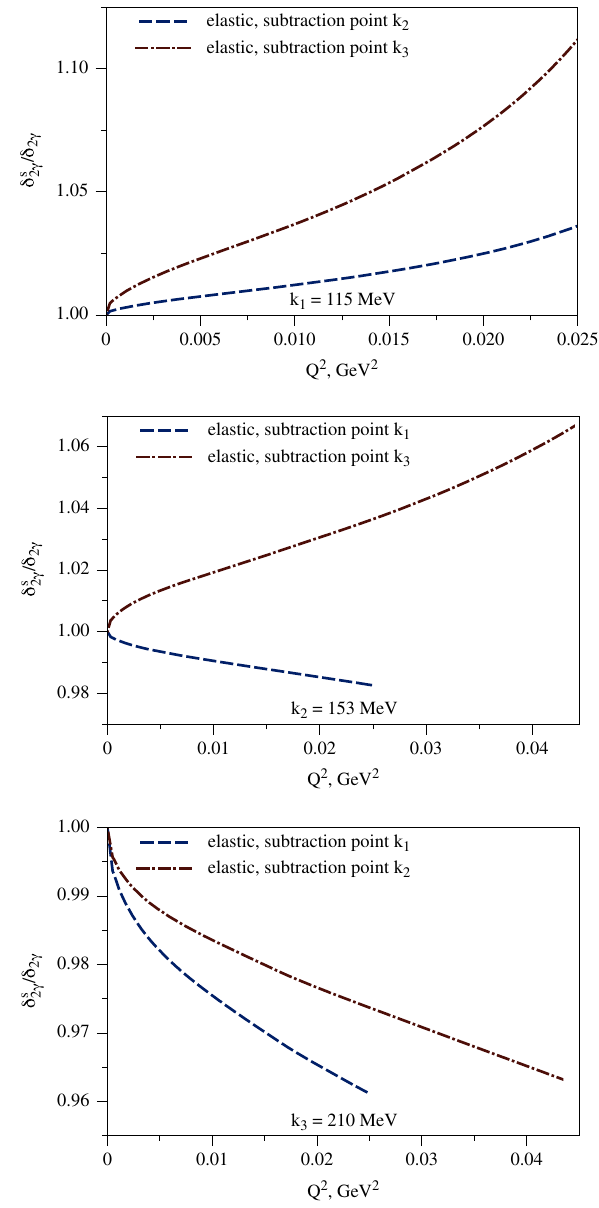
Fig. 6 The ratio of the TPE correction to the unpolarized elastic μ − p cross section within the subtracted DR framework to the correction of Ref. [31]. The results are shown by the blue dashed and red dashed- dotted curves corresponding to different subtraction points with the MUSE beam momenta: k 1 = 115 MeV , k 2 = 153 MeV , k 3 = 210 MeV